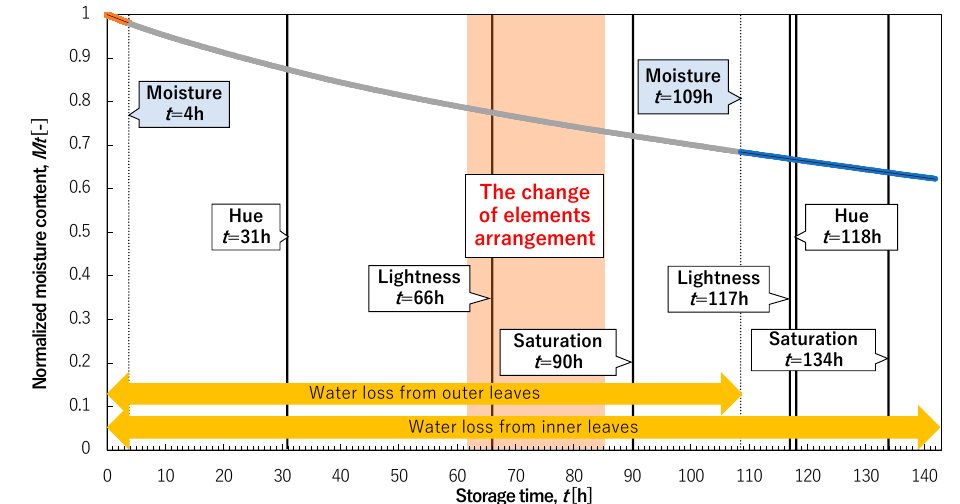
FFiigg.. 1111 TThhee cchhaarraacctteerriissttiicc ccuurrbb ooff tthhee ffrreesshhnneessss ooff lleettttuuccee.. 700